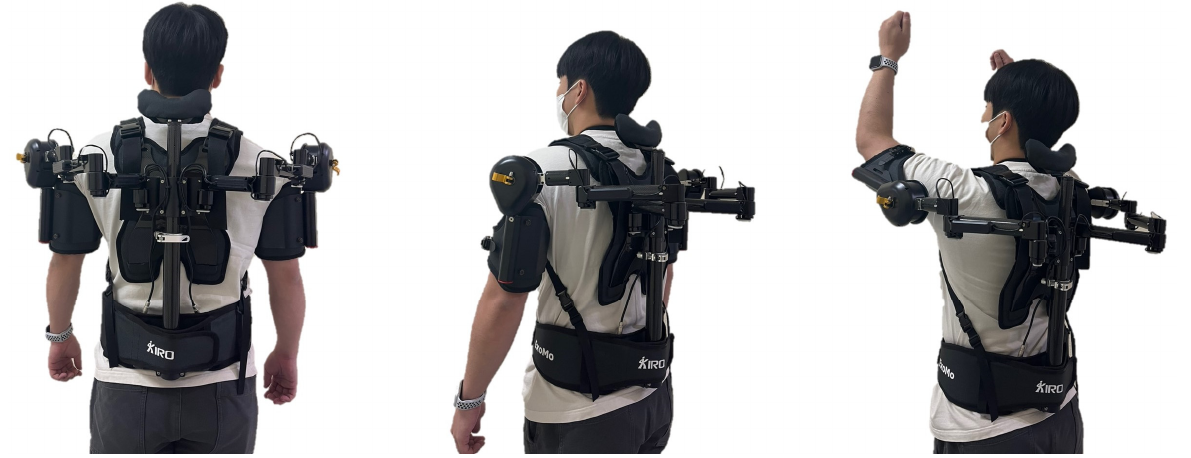
Figure 12. Shoulder muscle-assistive wearable device for work in unstructured postures.